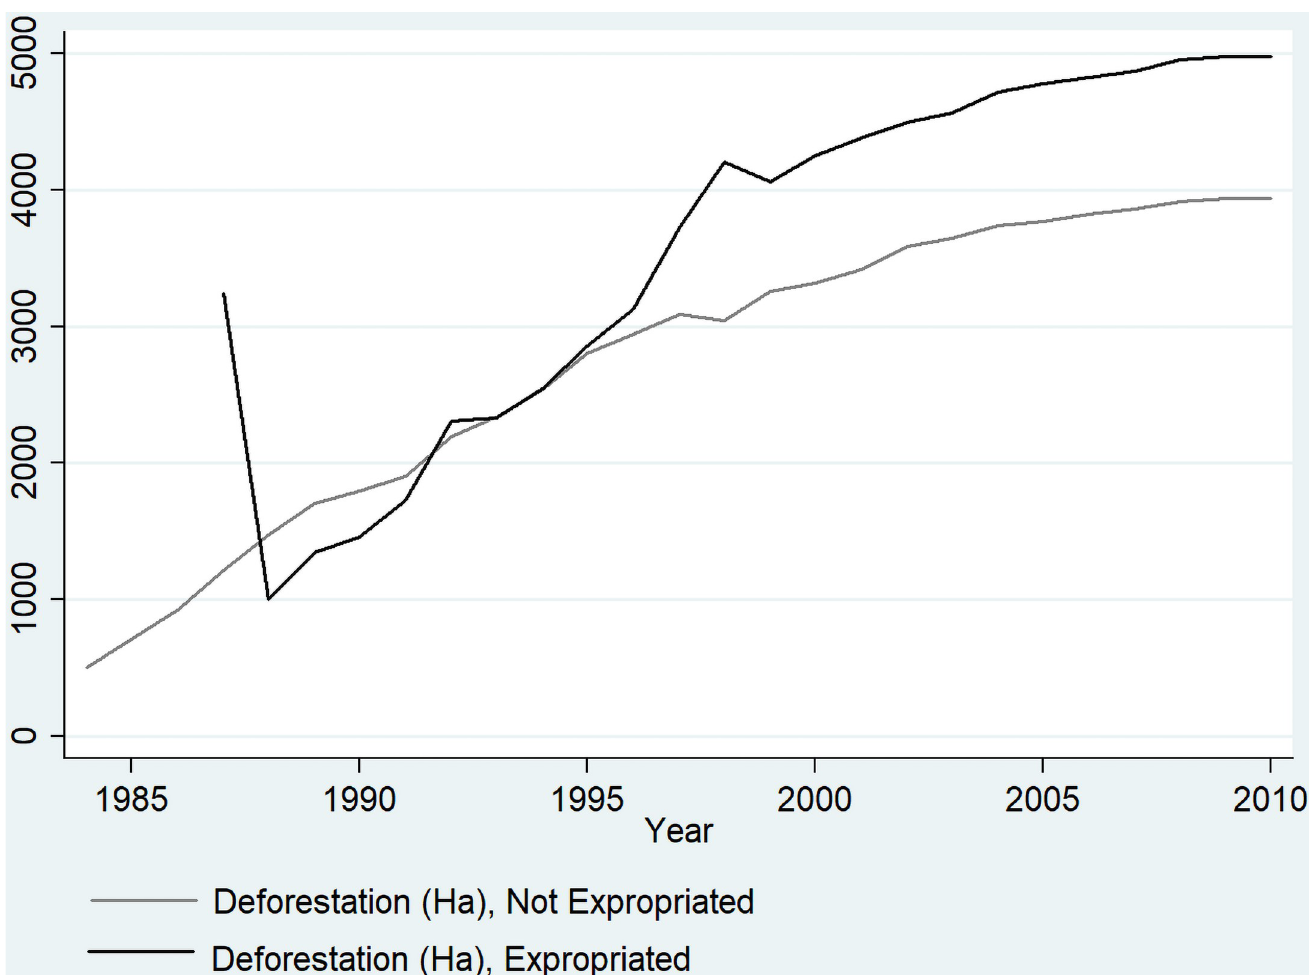
Fig 4. Average deforested area (hectares) on expropriated for settlement formation and properties which were not expropriated for settlement